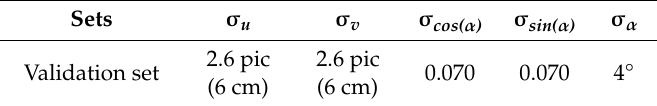
Table 1. Error of coordinates and rotation angle for the ground robot for navigation by the artificial neural network; size of the robot is 50 cm × 50 cm; pixel size corresponds to the distance 2.30 cm on the ground.